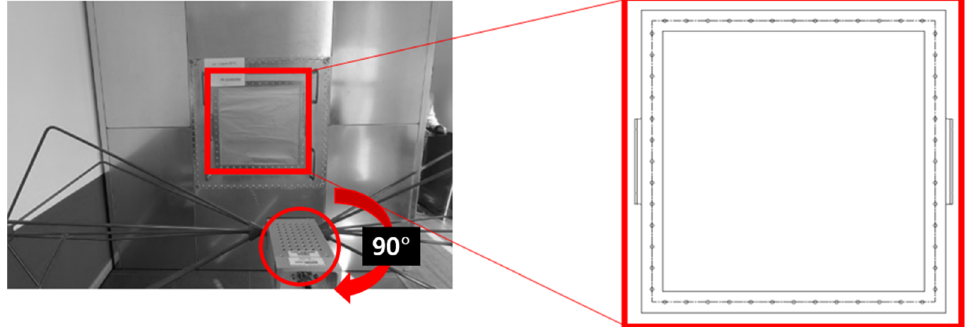
Figure 3. Experimental